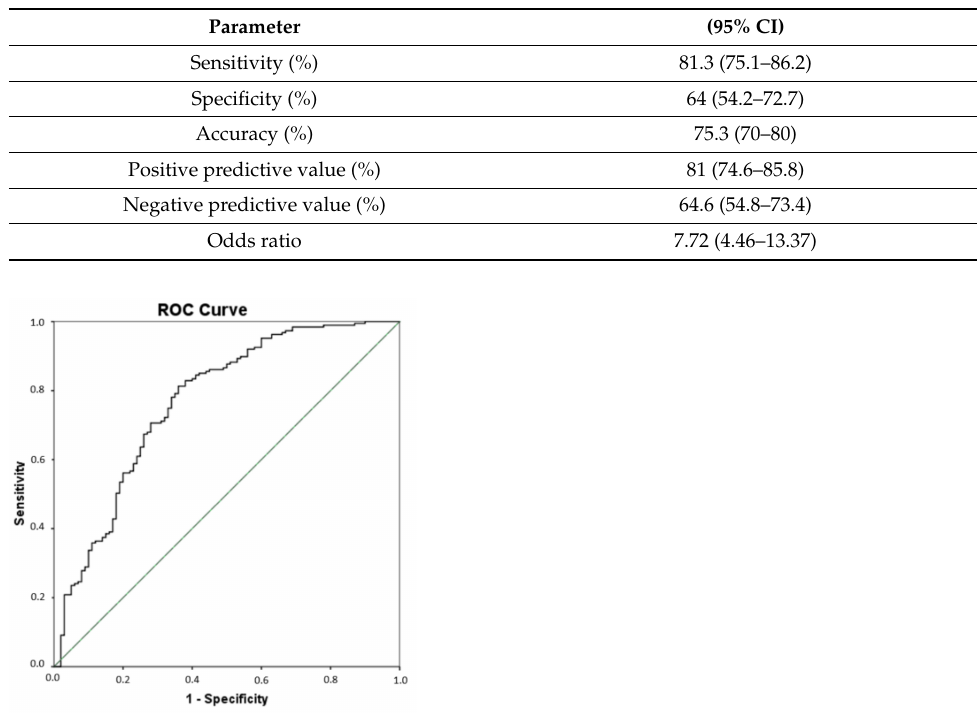
Table 5. Diagnosis indexes from the multivariate model of differential AD detection.